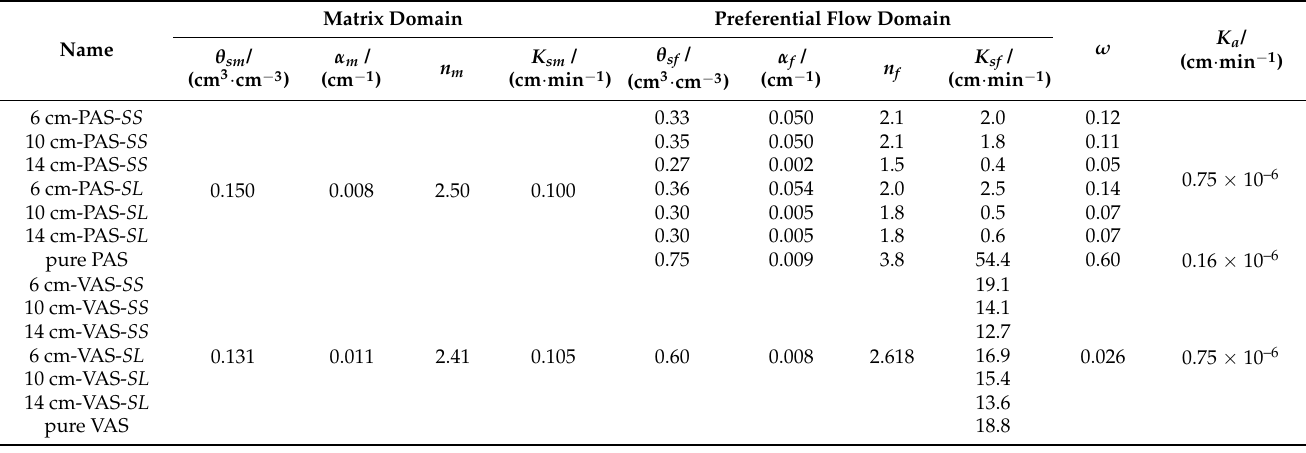
Table 4. Summary of substrate hydraulic